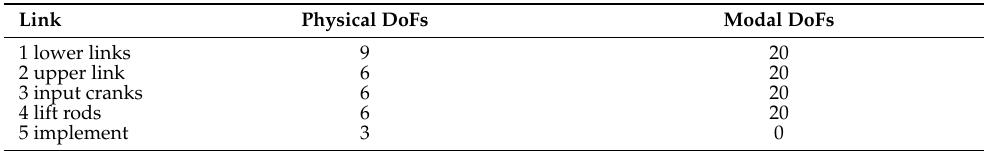
Table 2. Number of physical and modal DoFs retained for each